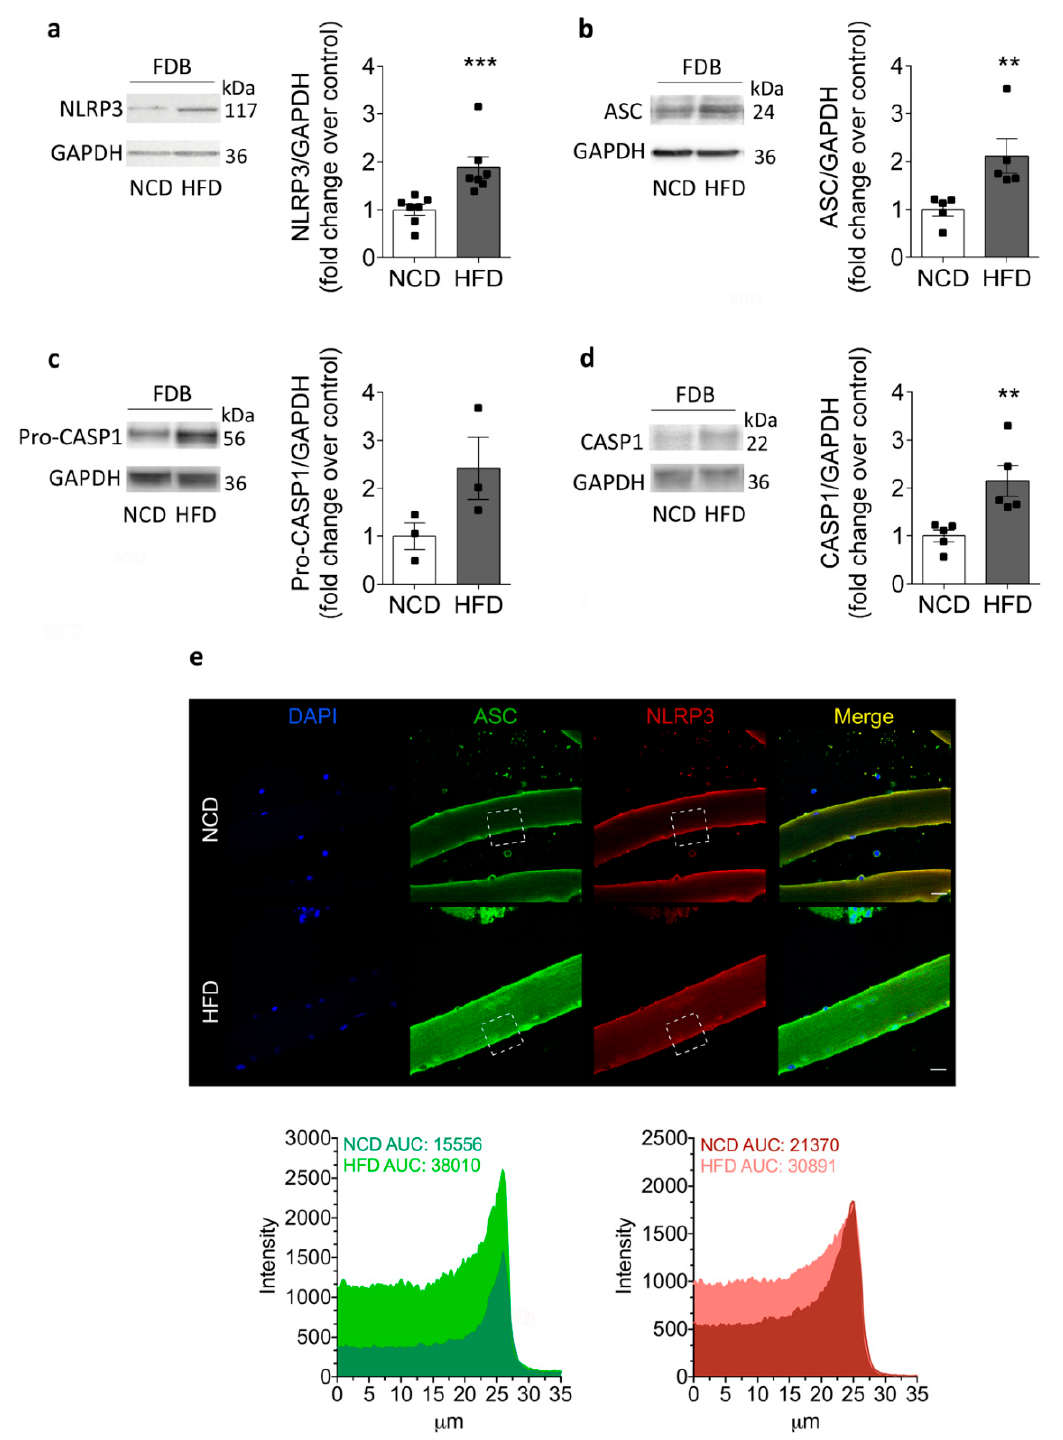
Figure 3. NLRP3 inflammasome protein content and localization in the skeletal muscle from HFD compared to NCD-fed mice. Representative Western blot and quantification showing ( a ) NLRP3, ( b ) ASC, ( c ) pro-caspase-1, and ( d ) caspase-1 protein content in homogenates. The samples were prepared from FDB muscle isolated from NCD- or HFD-fed mice after 8 weeks of an HFD. GAPDH was used as a housekeeping loading control. Each lane was loaded with 60 µ g of total protein. Values represent the mean ± SEM ( n = 3–7). ** p < 0.01 and *** p < 0.001, determined by Student’s t -test. ( e ) Representative confocal images of isolated adult FDB fibers from NCD- and HFD-fed mice illustrate the localization of ASC (green) and NLRP3 (red). DAPI staining of the nuclei is shown in blue. The area under curve (AUC) was measured on white squares, and quantified as fluorescence intensity. Scale bar: 20 μ m.